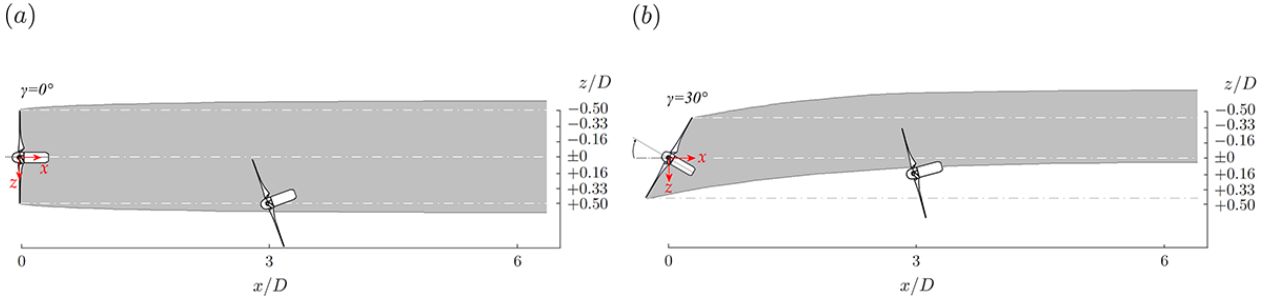
Figure 10. (a) Top view of the downstream turbine T2 operated at a lateral offset position (cid:49)z/D = + 0 . 50 and a yaw angle of γ T2 = − 20 ◦ in the wake of an upstream turbine T1 operated at γ T1 = 0 ◦ . (b) Top view of the downstream turbine T2 operated at a lateral offset position ( (cid:49)z/D = + 0 . 16) and a yaw angle of γ T2 = − 15 ◦ in the wake of an upstream turbine T1 operated at γ T1 = 30 ◦ .